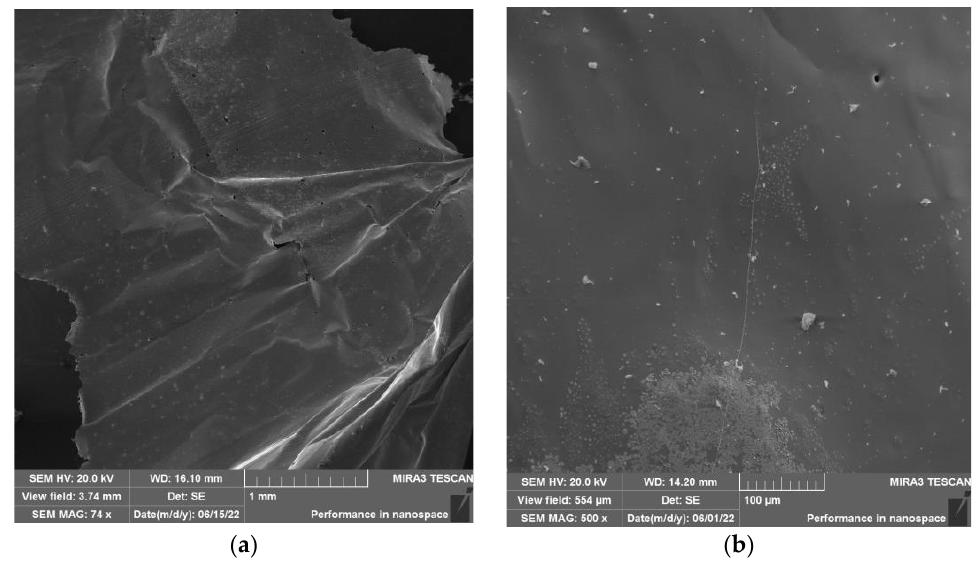
Figure 9. Morphology of the obtained zinc product (evaporation process under the temperature of 700 °C) in form of “foil” at ( a ) 1 mm magnification and ( b ) 100 µm magnification. Results of SEM analysis of the product in the form of “foil” is shown in Figure 9a,b. The morphology of this product is smooth and consistent.